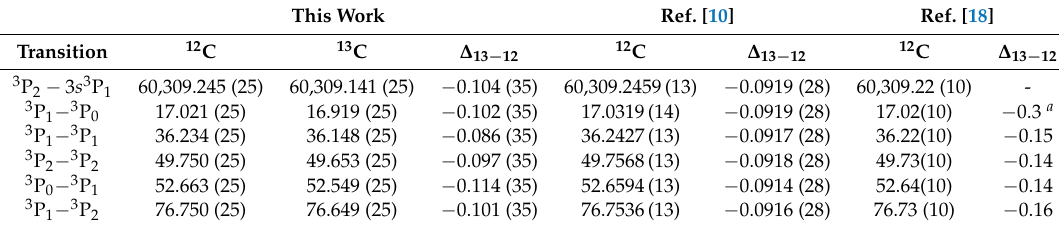
Table 3. Measured frequency and isotopic shift ( ∆ 13 − 12 ) of C I 3 P J – 3 s 3 P J transitions, with uncertainties indicated in parentheses. Note that the 12 C transition frequencies from [10] are computed values. The uncertainty of isotopic shifts from [18] is estimated by taking measurement uncertainties from 12 C and 13 C in quadrature. All values are given in cm − 1 .